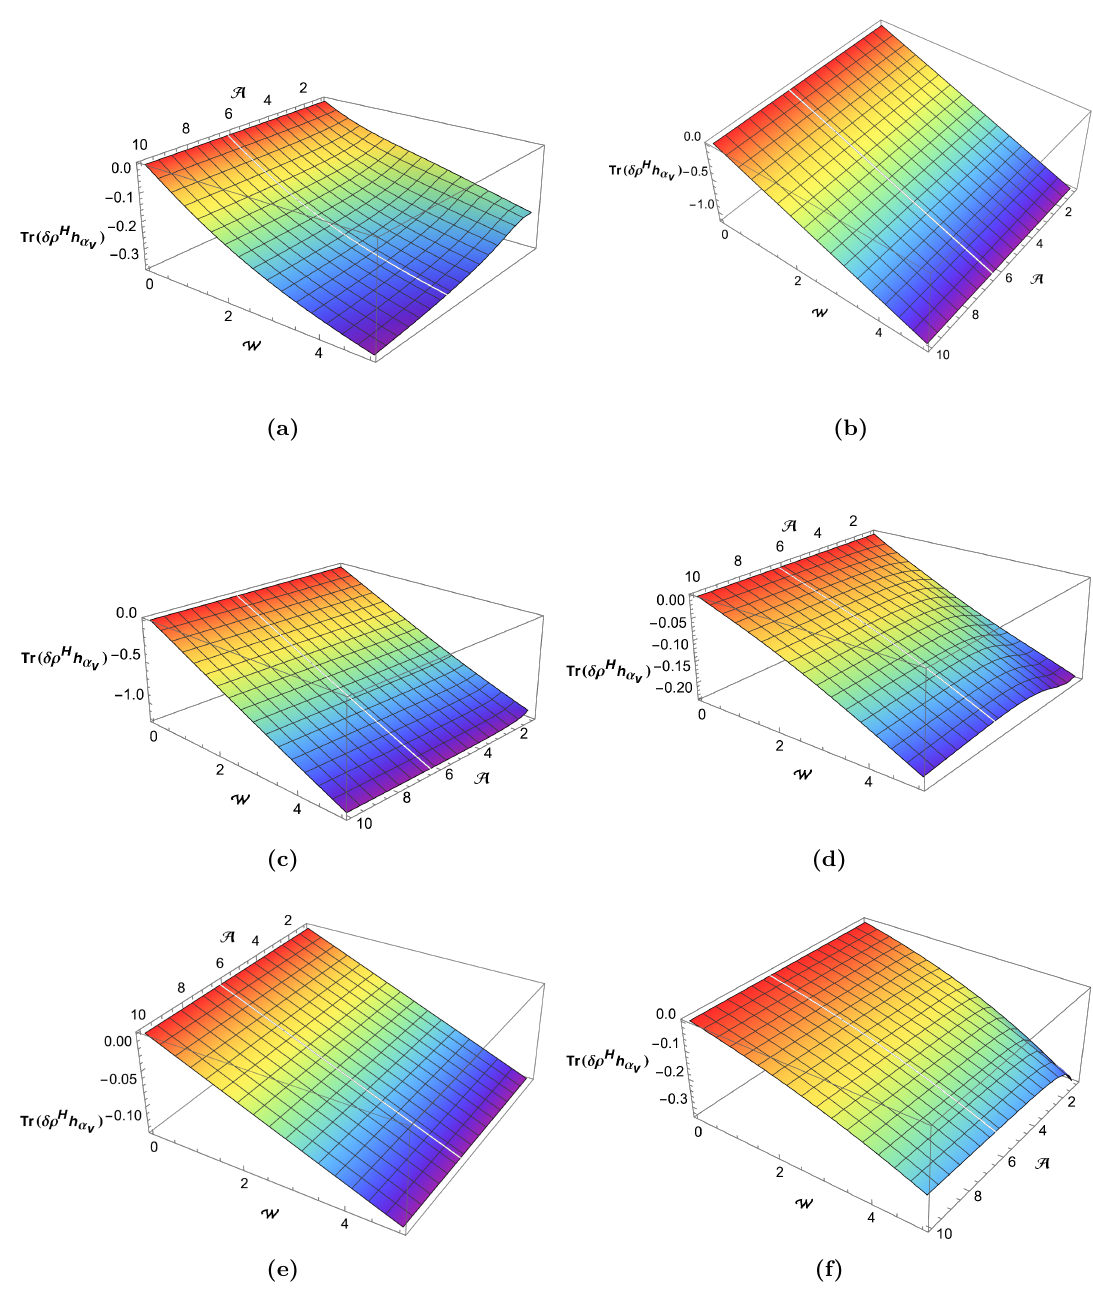
) are plotted with v = b = 0 . 9 for α = 0 . 2 , 1 . 0 , 1 . 2 , respectively. Plots 1 2 a H = − b = 0 . 9 for α = 0 . 2 , 1 . 0 , 1 . 2 , 1 2 a H